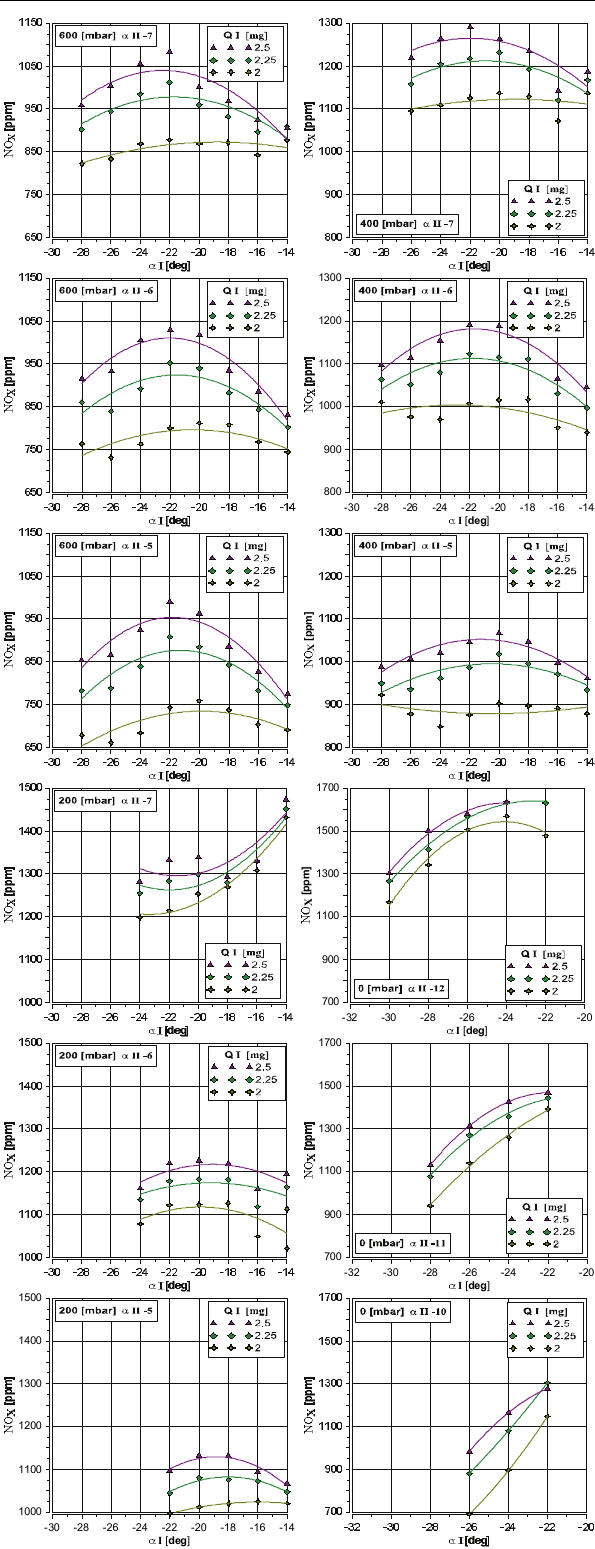
Fig. 3. Characteristics of variability of nitrogen oxides’ (NO x ) content in exhaust for different injection parameters of diesel fuel dose